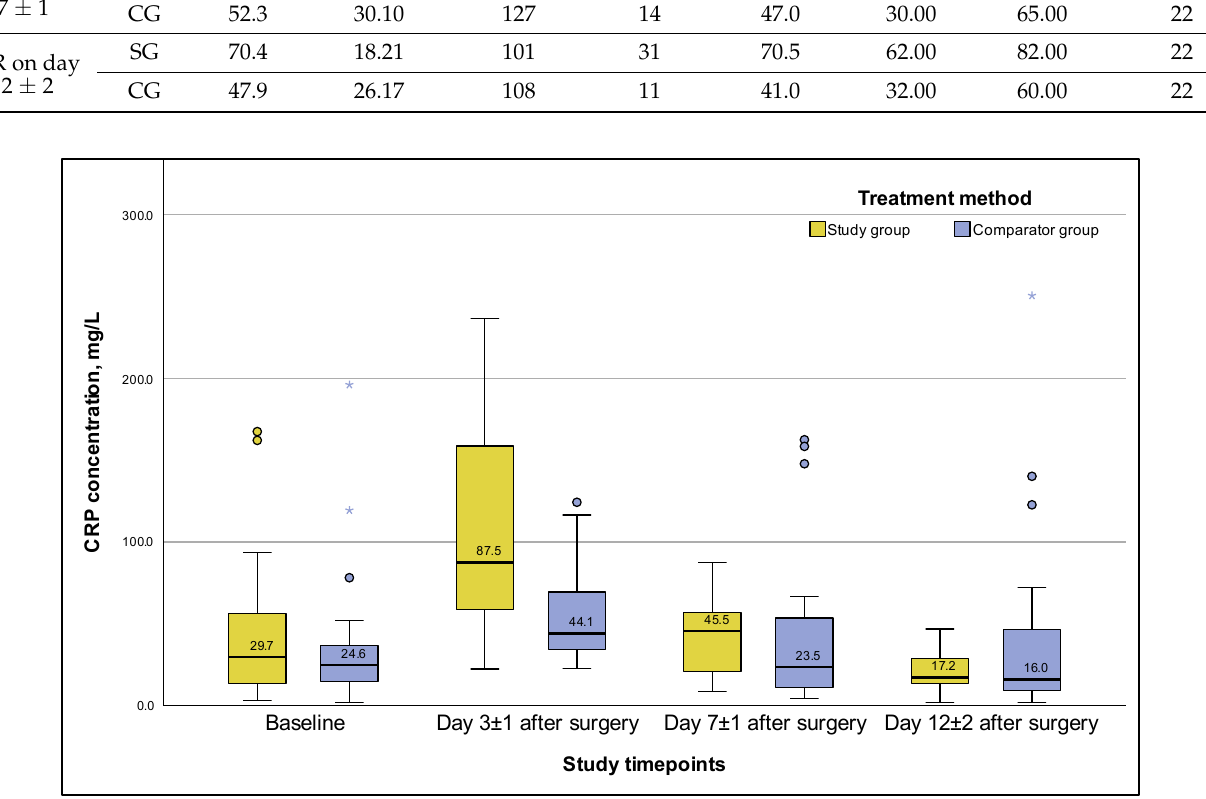
Figure 3. C-reactive protein concentration during PJI treatment for 12 ± 2 days after surgery (ITT population). Note: whiskers are based on 1.5 interquartile range, circles and asterisks are outliers.